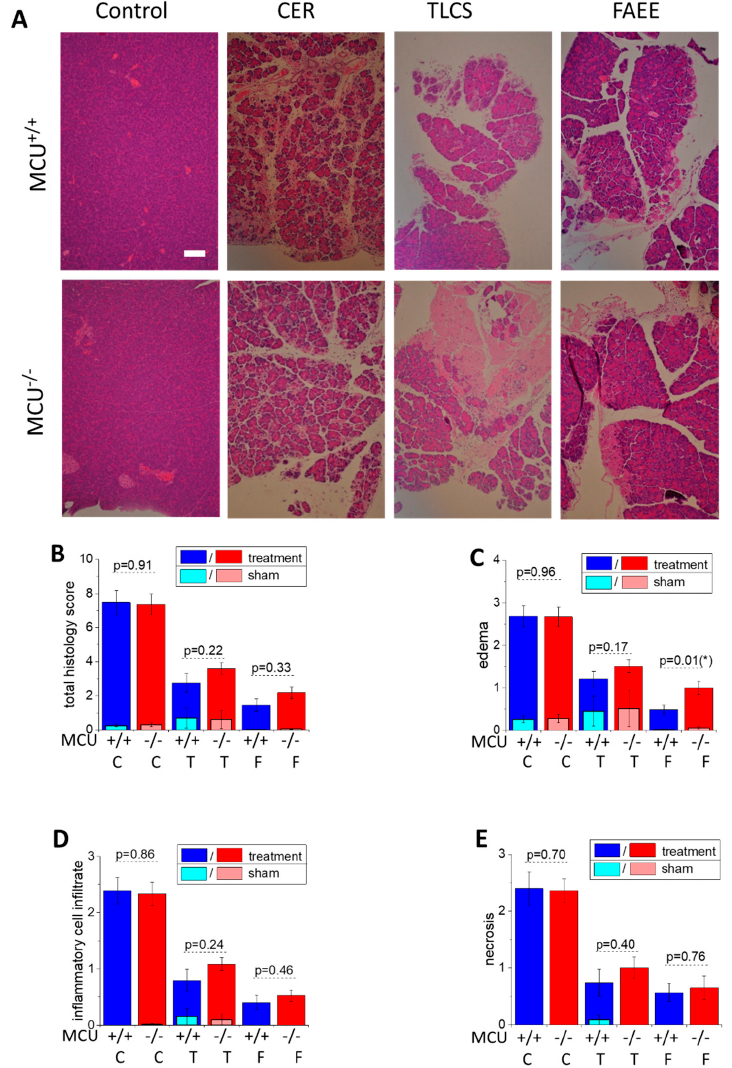
Figure 3. MCU knockout does not reduce histopathology scores in CER-AP, TLCS-AP and FAEE-AP. ( A ) Representative images of pancreatic sections demonstrating histopathology changes (hematoxylin and eosin staining; scale bar represents 100 μ m). The models of AP are abbreviated on the graph as C for CER-AP, T for TLCS-AP and F for FAEE-AP. One representative control experiment (for CER-AP) is shown in this part of the figure; all saline controls had low total histopathology scores (see below). (B–E) The histopathology scores. The bars indicate the mean values ± the standard errors. In all parts of this figure, dark bars represent the treatment groups, while the light bars represent control (sham) groups (see Materials and Methods Section and text boxes above the bars specifying the color coding). There were no statistically significant differences between the control/sham groups of MCU − / − and MCU +/+ mice in the histopathology scores for any type of control/sham experiments ( p > 0.05). The scores for all treatment groups were significantly different ( p < 0.05) from the scores for the corresponding control (sham) groups. ( B ) The total histopathology score for MCU − / − and MCU +/+ mice. (C–E) The component scores: ( C ) edema (asterisk indicates p < 0.05); ( D ) inflammatory cell infiltration; and ( E ) necrosis. The p values for comparison between MCU − / − and MCU +/+ mice in AP models are indicated above the corresponding bars. In this part of the study, 12 MCU − / − and 13 MCU +/+ mice were used for the CER-AP; 7 MCU − / − and 10 MCU +/+ for the TLCS-AP; and 8 MCU − / − and 6 MCU +/+ for the FAEE-AP. Histopathological scores for AP induced in MCU − / − and MCU +/+ did not reveal significant di ff erences except for edema in FAEE-AP, which had a higher score for MCU − / − ( p = 0.01; marked with asterisk on the